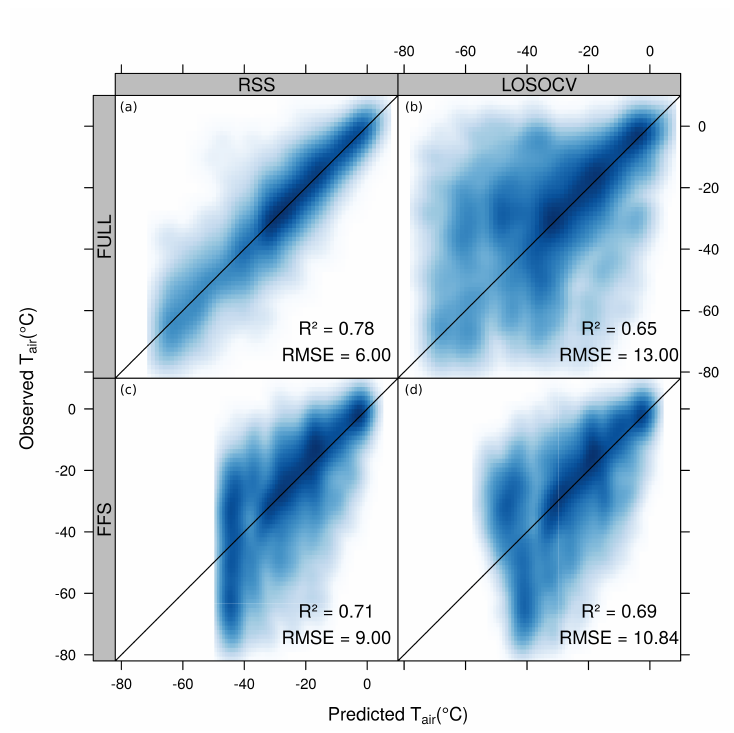
Figure 3. Agreement between measured T air and predicted T air using Cubist as modeling tool. Models were first trained using the full set of predictor variables (FULL) and second using only LST and month as predictors that were revealed during forward feature selection (FFS). Two different validation strategies were used: Comparison to a 60% random subset of the total dataset (RSS), as well as Leave-One-Station-Out Cross-Validation (LOSOCV). The problem of overfitting becomes obvious by comparing the performance of the full model validated by RSS ( a ) with the performance of the full model validated by LOSOCV ( b ). Using the 2-variable model, the performance validated by RSS decreased ( c ) compared to the full model. Only slight differences between RSS and LOSOCV (c,d) indicate that there is no considerable overfitting in the 2-variable model. The most important point is that the 2-variable model could improve the LOSOCV performance ( d ) compared to the full model. Data are represented as smoothed scatter plots where the intensity of the color represent the data point